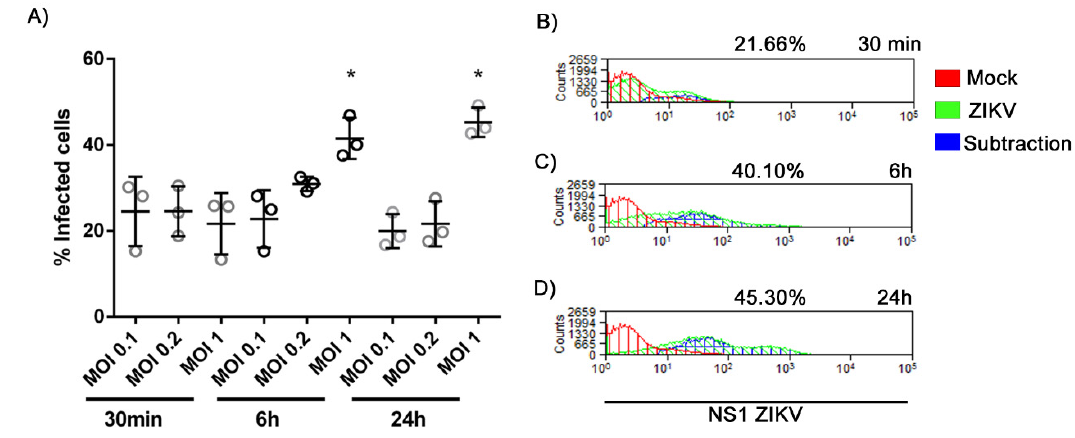
Figure 2. Percentage of HMC-1 cells infected with di ff erent MOIs of ZIKV. HMC-1 cells were incubated with ZIKV at MOIs of 0.1, 0.2 or 1 for 30 min and prepared for flow cytometry, or 1 h followed by 6 h or 24 h incubation before analysis. Cells were permeabilized, fixed and stained with the mouse monoclonal IgG antibody against ZIKV non-structural protein NS1 followed by incubation with the Alexa 488-conjugated anti-mouse. Panel ( A ) presents the individual percentages of HMC-1 cells expressing the NS1 protein under the di ff erent conditions from three independent experiments. Averaged histograms from the experiments with an MOI of 1 are shown in ( B ) 30 min, ( C ) 1 h with 6 h and ( D ) 1 h with 24 h infection. For negative control, cells were incubated with mock viral stocks. * Statistically significant di ff erences between groups (same time of infection) assessed by a Mann–Whitney test ( p < 0.05).